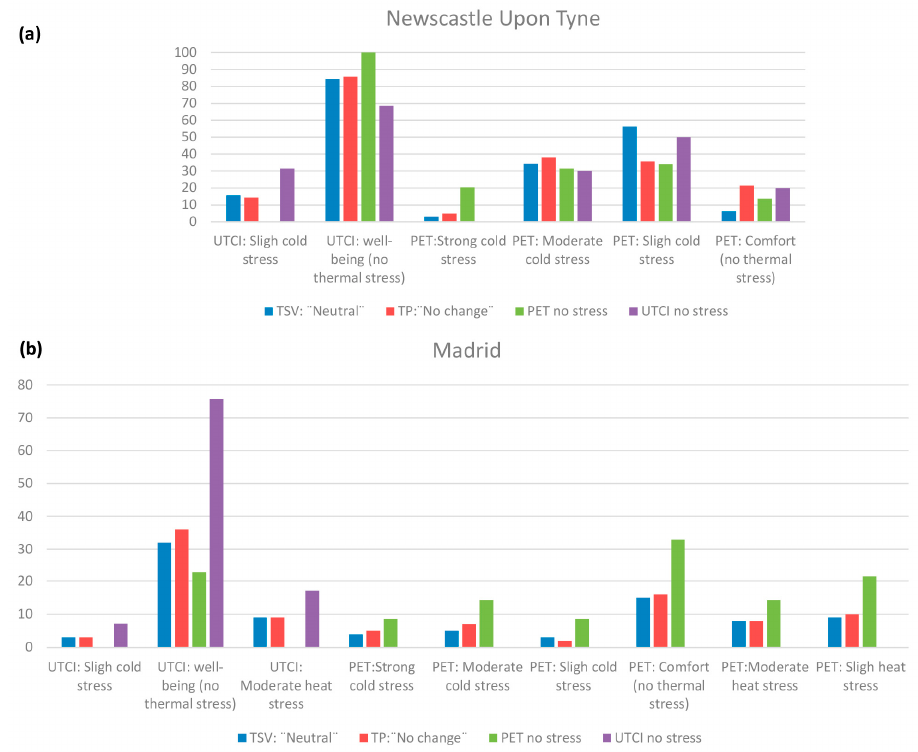
Figure 8. PET and UTCI and comparison with MTSV for ( a ) Newcastle upon Tyne and ( b ) Madrid.